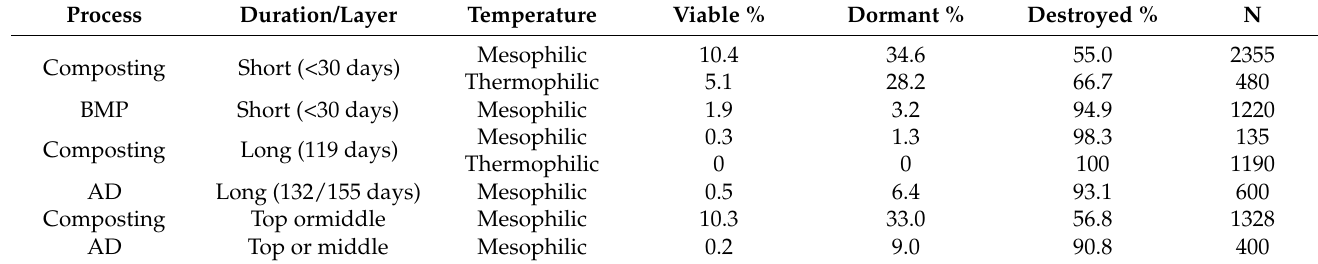
Table 4. Combined results from different experiments showing the most important findings about the effect of treatment process, duration of treatment, temperature and depth of samples (layer) on seed survival of L. polyphyllus Lindl. Proportions in each viability class is presented as average and total number of seeds in combined treatments.